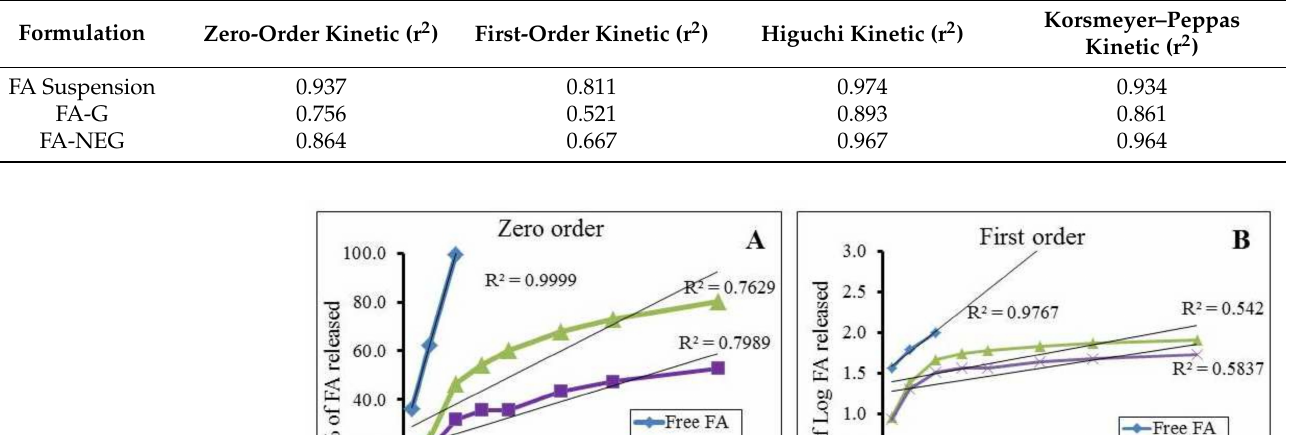
Table 5. Kinetics of FA release from the studied formulations.